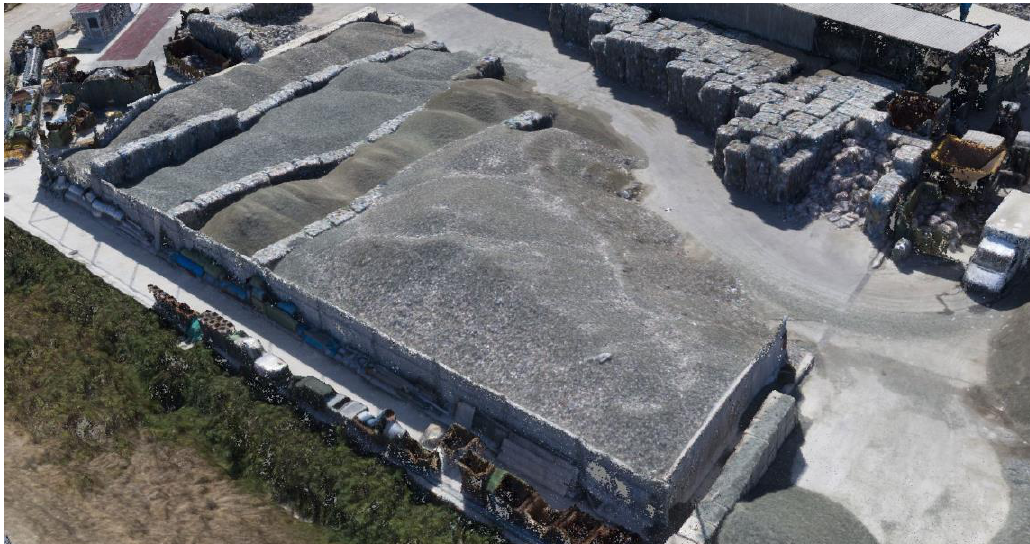
Figure 15. Dense cloud generated with Photoscan.